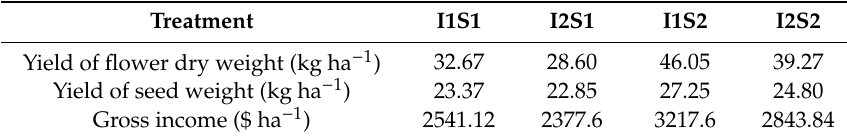
Table 6. Calculation of gross income in each treatment per ha (USD).